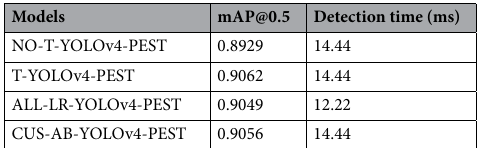
Table 7. Basic performance indicators of each model.